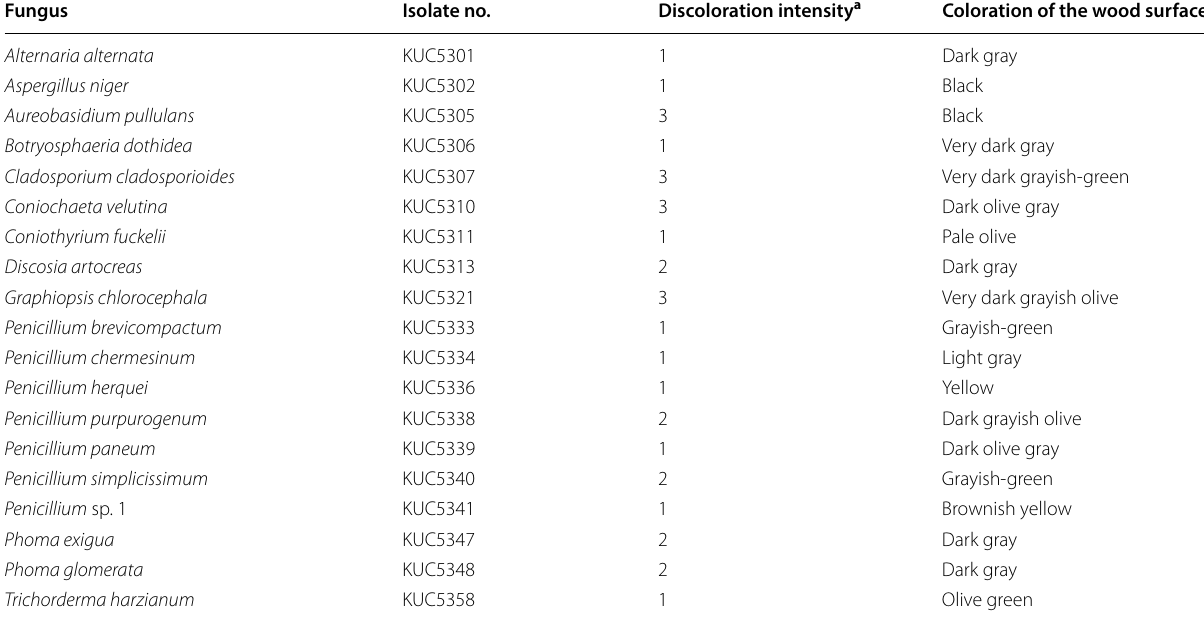
Table 1 Wood discoloration and color of wood surface 4 weeks after inoculation with selected ascomycetes previously isolated from WCHs